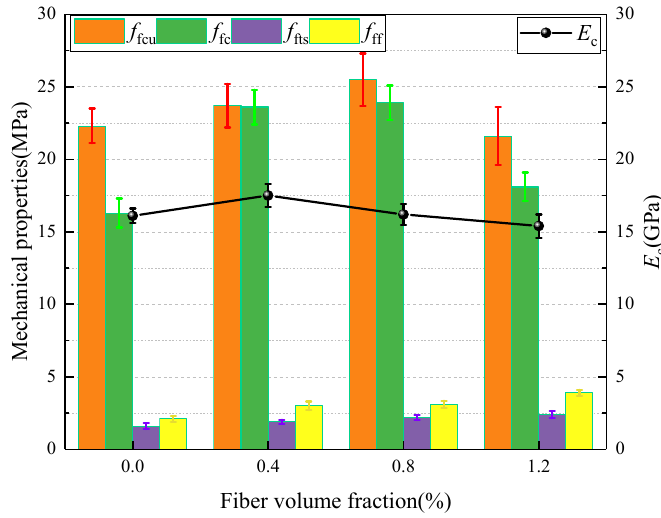
Figure 7. Mechanical properties of self-compacting SFRC.